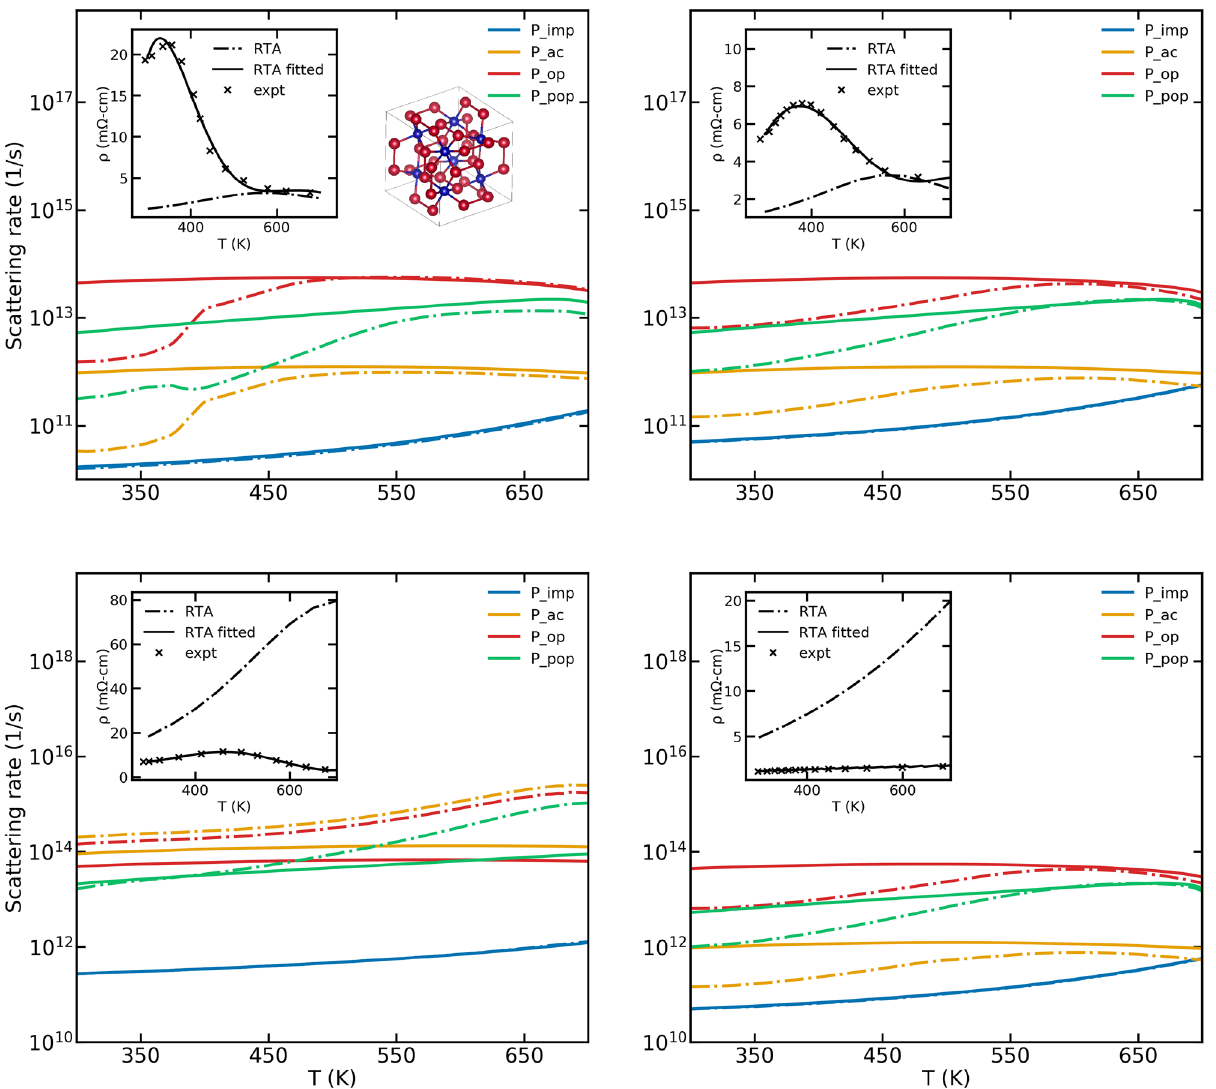
Figure 7. A comparison of the scattering rates in CoSb 3 obtained using the original scattering models (RTA) and those obtained using the fitting procedure (RTA fitted ) are shown. The top left panel corresponds to a p-type sample with a doping concentration of 1.2 × 10 17 cm − 3 while the top right panel corresponds to a p-type doping of 4.4 × 10 17 cm − 3 . The bottom left panel corresponds to an n-type sample with a doping concentration of 152 × 10 17 cm − 3 while the bottom right panel corresponds to an n-type doping of 1380 × 10 17 cm − 3 . The inset shows the electrical resistivity calculated using the both the original and fitted scattering rates. The experimental data have been obtained from Ref. 35